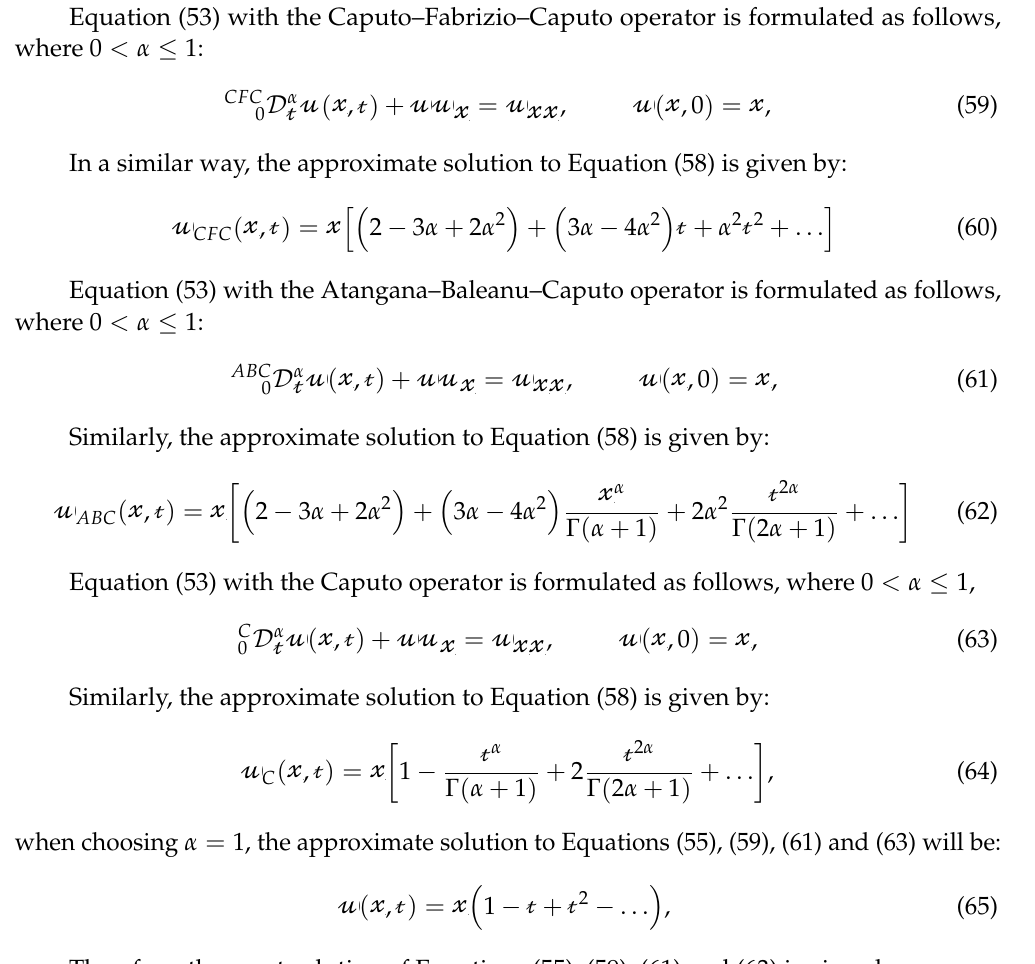
Table 2. The values of the approximate and exact solutions at 𝛼 = 1 and absolute error of Equa- tions (55), (59), (62), (64) and (66) at different values of 𝓉, 𝓍 .